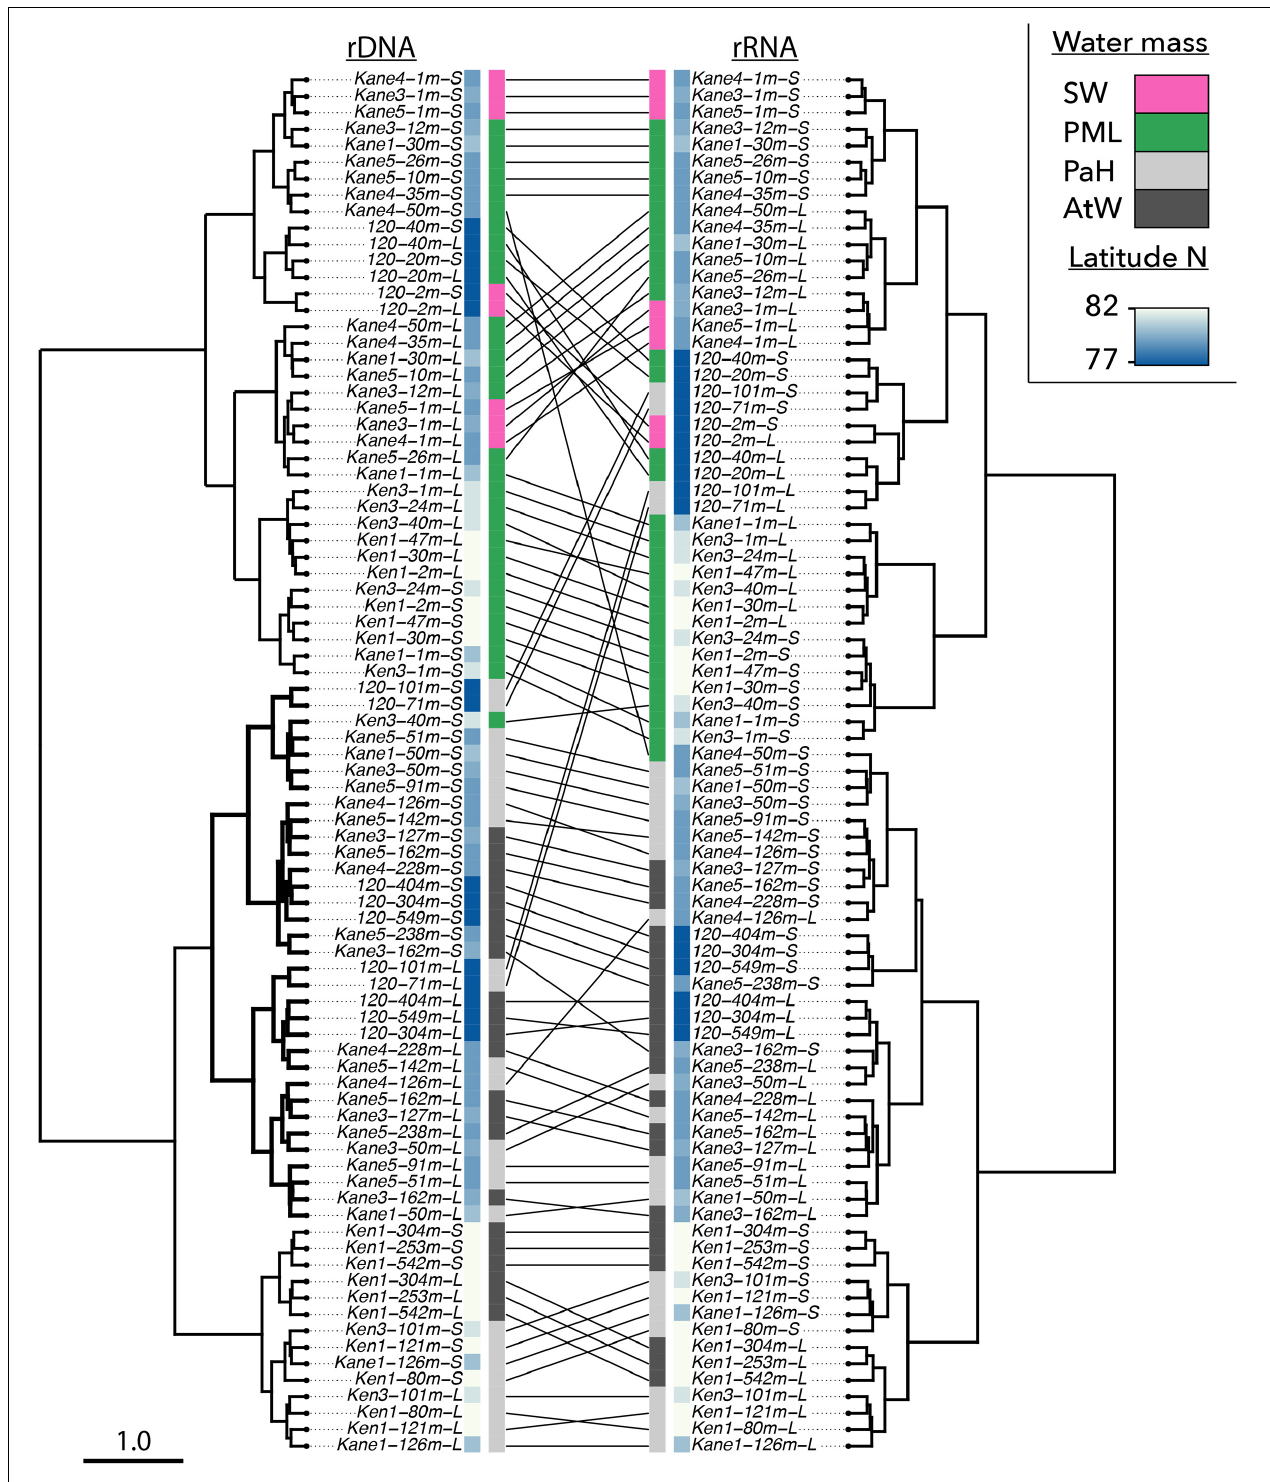
FIGURE 4 | Beta-diversity shown by Bray–Curtis Cluster analyses based on community dissimilarity from the rDNA (left) and rRNA (right) community matrices. In this figure large and small fraction are shown separately. Sample names consist of sampling station, the depth and the fraction (L for large and S for small). Lines between the left and right clusters connect rDNA samples to the corresponding rRNA samples. The inner colored bars indicate the latitude of the samples (in blues), and the water mass classification as given in Figure 2 . Here, pink for surface water (SW), green for polar mixed layer (PML) waters, light gray for Pacific Halocline (PaH), and dark gray for deep Atlantic Water